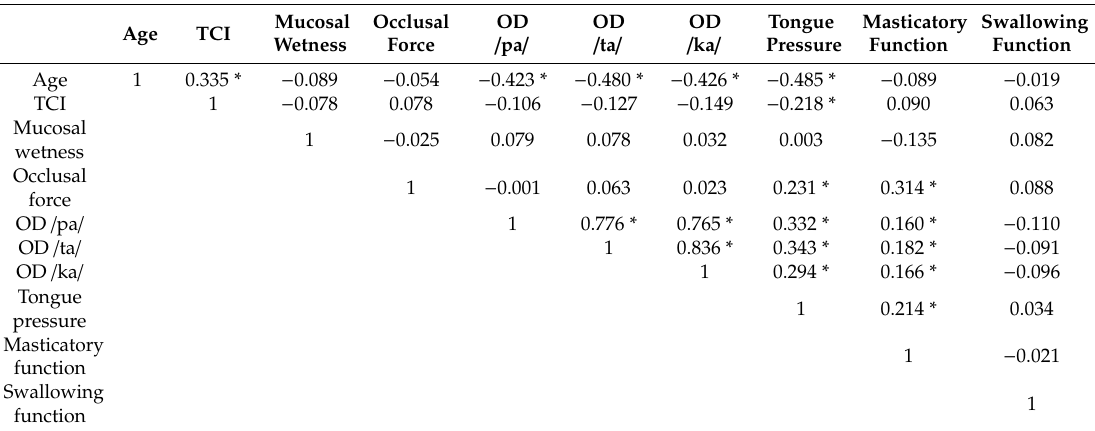
Table 2. Bivariate correlation analyses of the